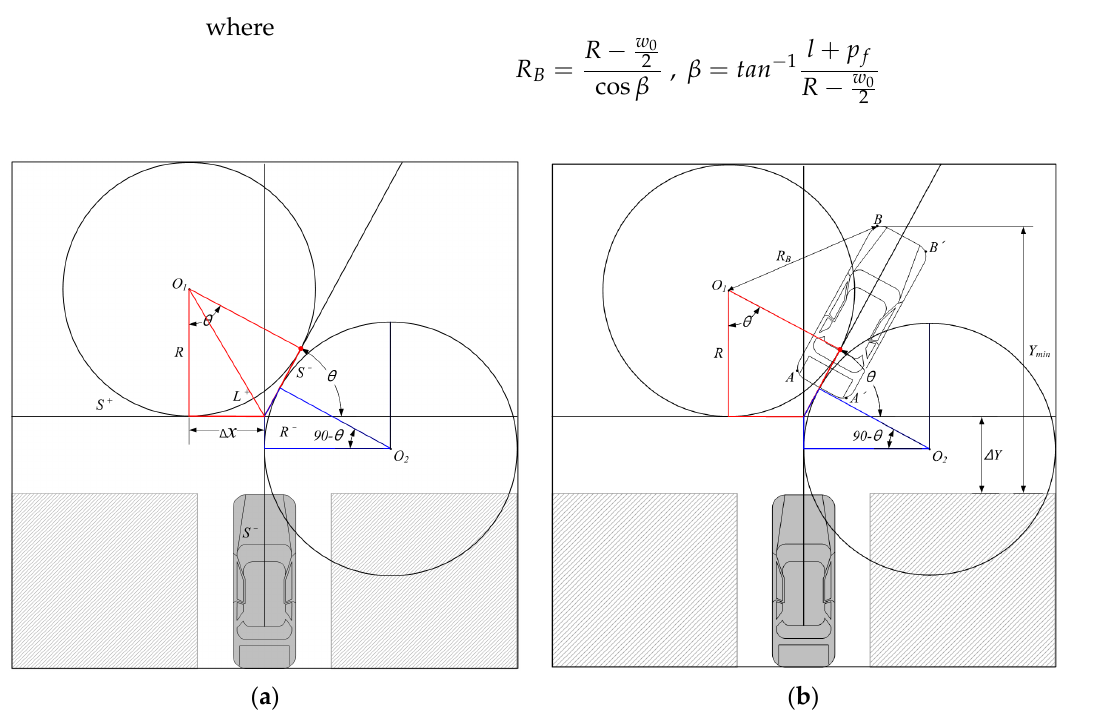
Figure 3. (𝑆 (cid:2878) 𝐿 (cid:2878) 𝑆 (cid:2879) 𝑅 (cid:2879) 𝑆 (cid:2879) ) perpendicular parking: 45° < 𝜃 < 90° : ( a ) Parking path; ( b ) surrounding (cid:0) (cid:1) S + L + S − R − S − Figure 3. perpendicular parking: 45 ◦ < θ < 90 ◦ : ( a ) Parking path; ( b ) surround- space. ing space.